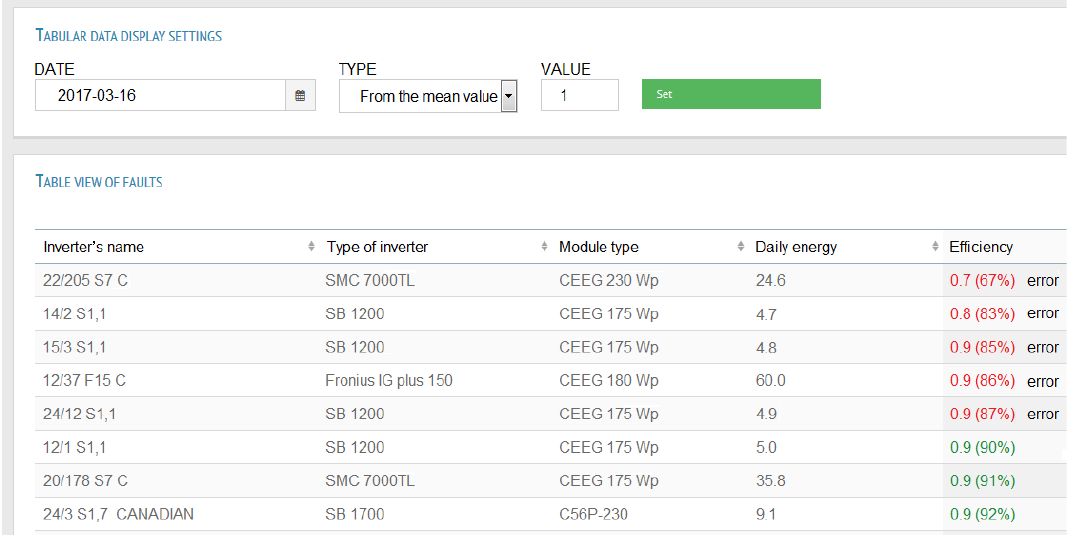
Figure 3. Data output of the monitoring system Solarmon-2.0.